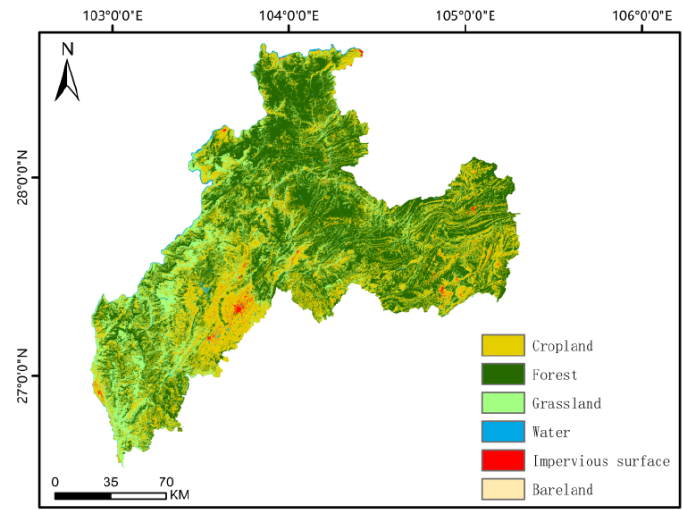
Figure 2. Zhaotong City’s land cover types.